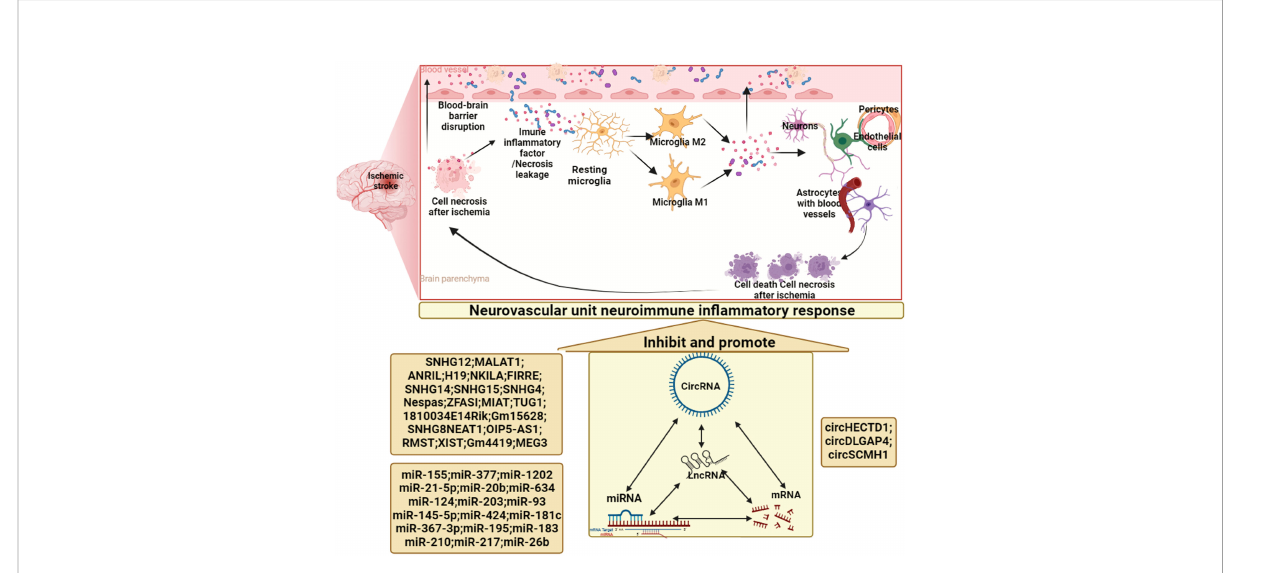
FIGURE 5 Non-coding RNA in neuroin fl ammation and immune regulation in cerebral infarction/ischemia-reperfusion